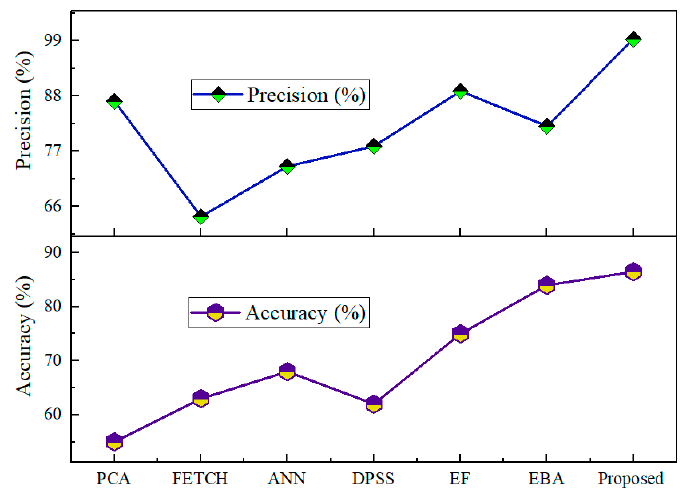
Figure 17. Comparison of Accuracy and precision of existing with the proposed method.